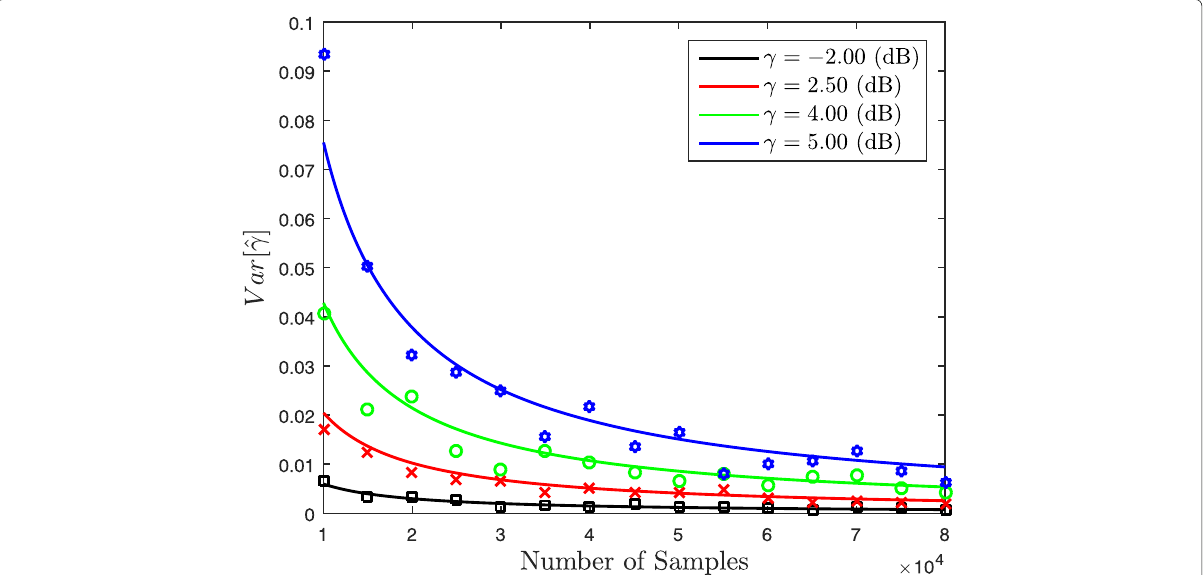
Fig. 5 Variance of the estimate ˆ γ as a function of the number of samples N for different values of SNR γ and 64-QAM modulation considering κ − μ fading with κ = 1.1 and μ = 0.3